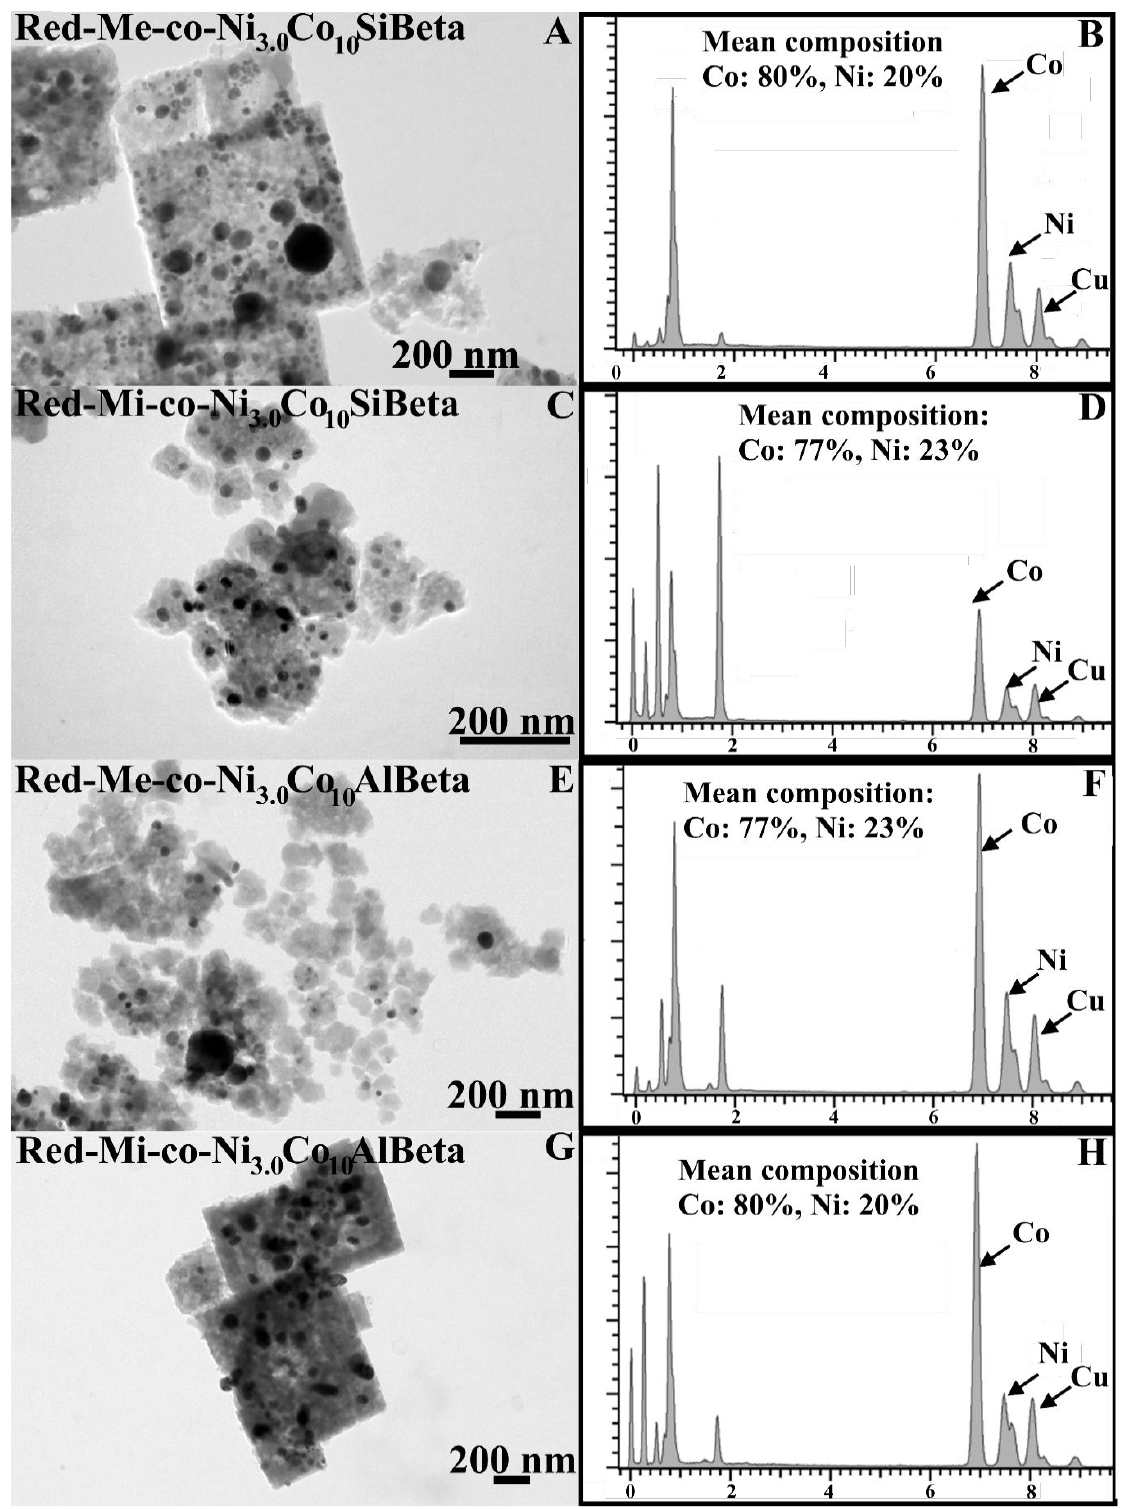
Figure 7. TEM bright field micrographs ( A , C , E , G ) with a representative EDS spectra ( B , D , F , H ) of Red-Me-co-Ni 3.0 Co 10 SiBeta, Red-Mi-co-Ni 3.0 Co 10 SiBeta, Red-Me-co-Ni 3.0 Co 10 AlBeta, Red-Mi-co-Ni 3.0 Co 10 AlBeta.